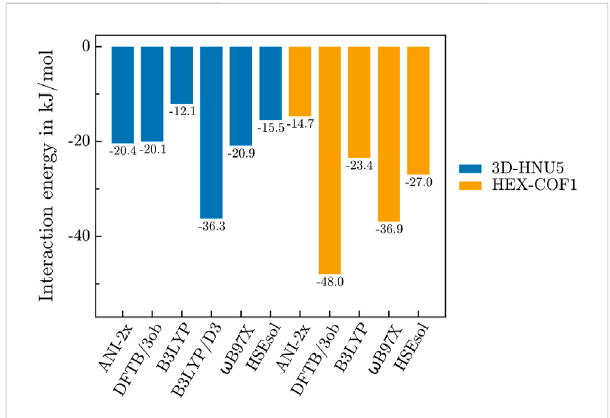
FIGURE 2 Interaction energies of 3D-HNU5 (unit cell) and HEX-COF1 (1 × 1 × 3 supercell) with a single CO 2